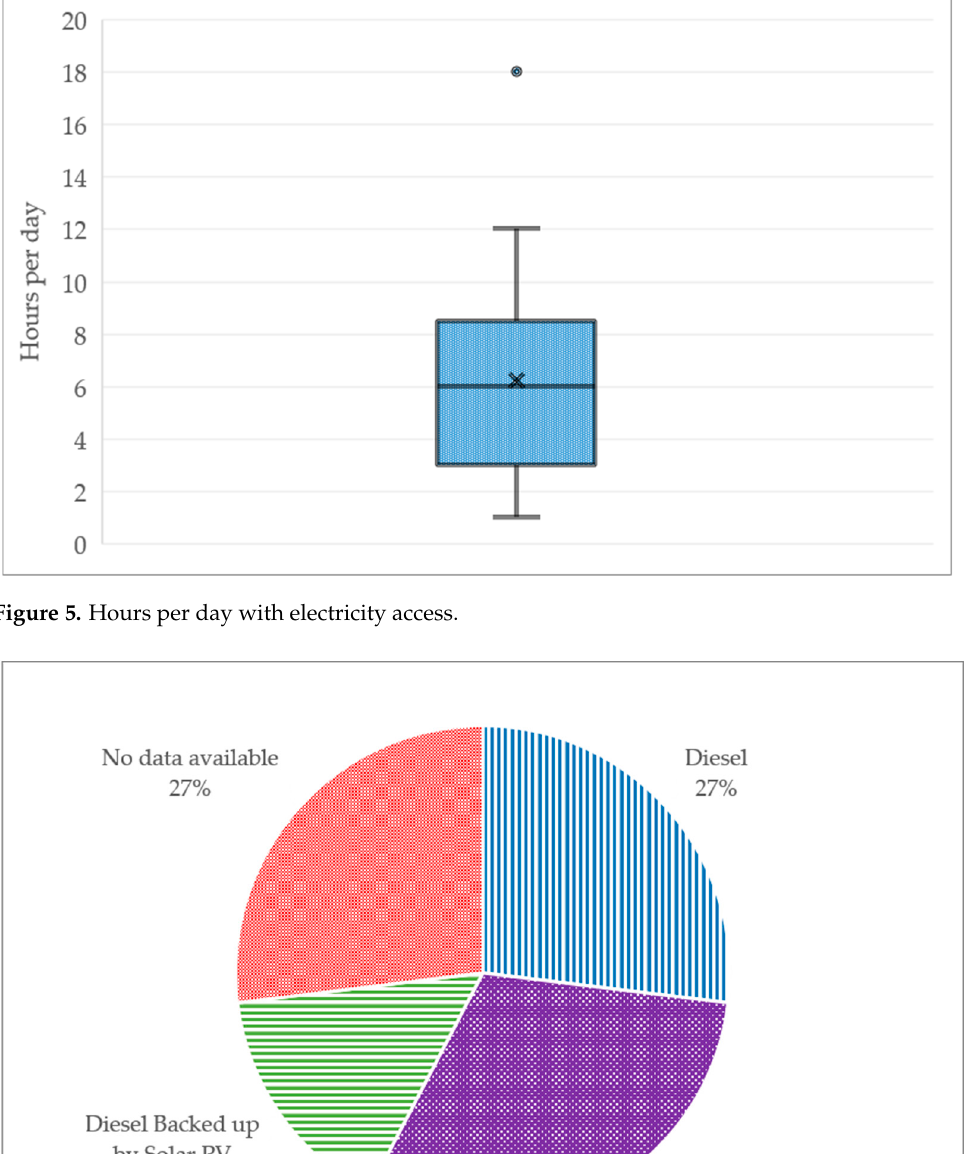
Figure 4. Source of electricity for HCFs with reliable electricity access.